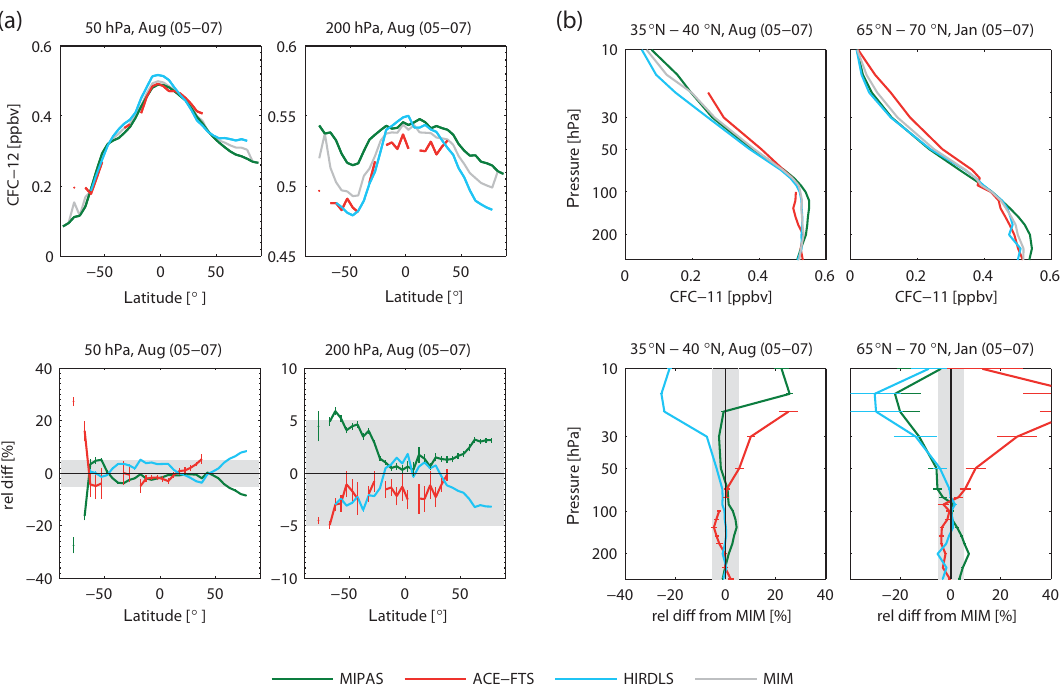
Figure 6. Meridional zonal mean CFC-12 profiles at 50 and 200hPa for August 2005–2007 (upper row) and relative differences between the individual instruments and the MIM profiles (lower row) are shown in panel (a) . Vertical monthly zonal mean CFC-12 profiles for 35–40 ◦ N in August and 65–70 ◦ N in January 2005–2007 (upper row) and relative differences between the individual instruments and the MIM profiles (lower row) are shown in panel (b) . The grey shading indicates the ± 5% difference range. Bars indicate the uncertainties in the relative